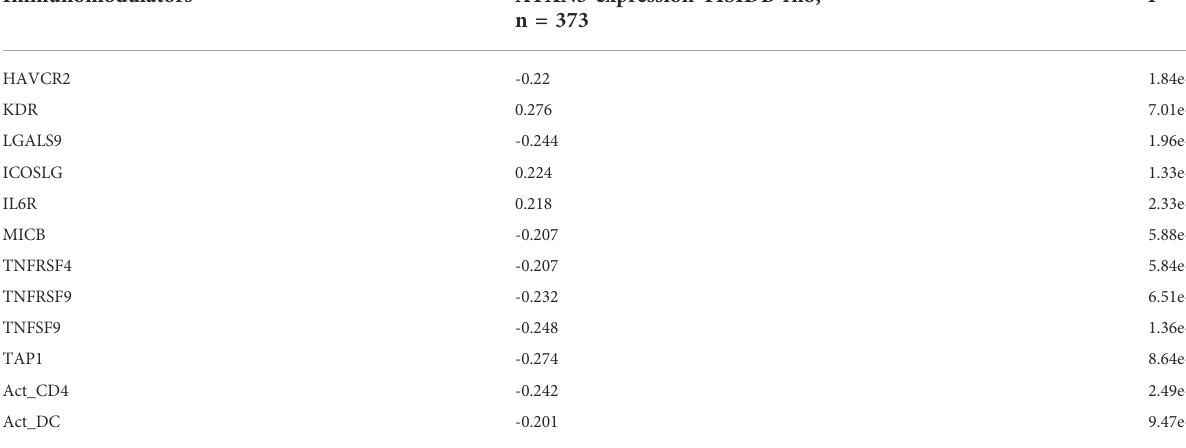
TABLE 2 Correlation of ATXN3 expression with immunomodulators based on TISIDB database. Immunomodulators ATXN3 expression TISIDB rho, n =